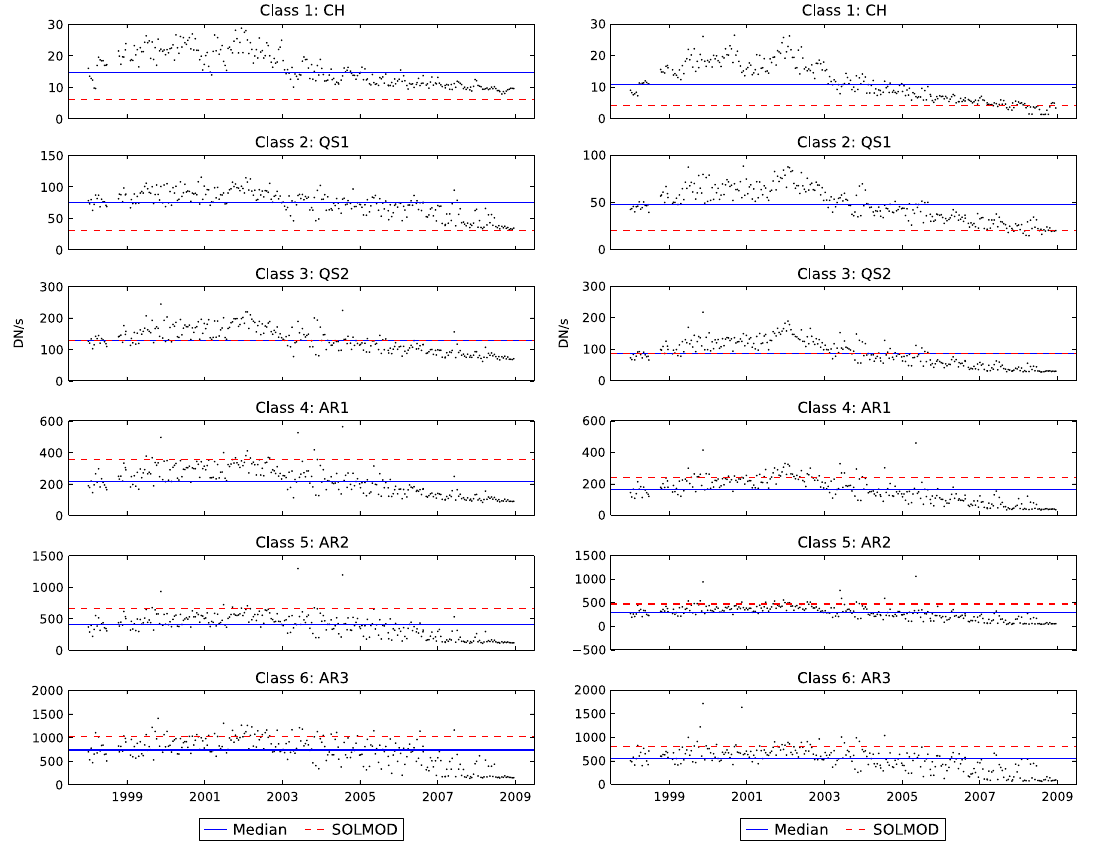
Fig. 4. Evolution of centers of classes computed with SPoCA2 on a frame-by-frame basis on EIT 171 Å (left) and 195 Å (right) images. The dataset consists of one image per bandpass every 14 days during the period 1 January 1998 until 31 December 2008. The blue solid lines represent the median value over the whole period, while the red dotted lines are the values found using the SOLMOD ratios.